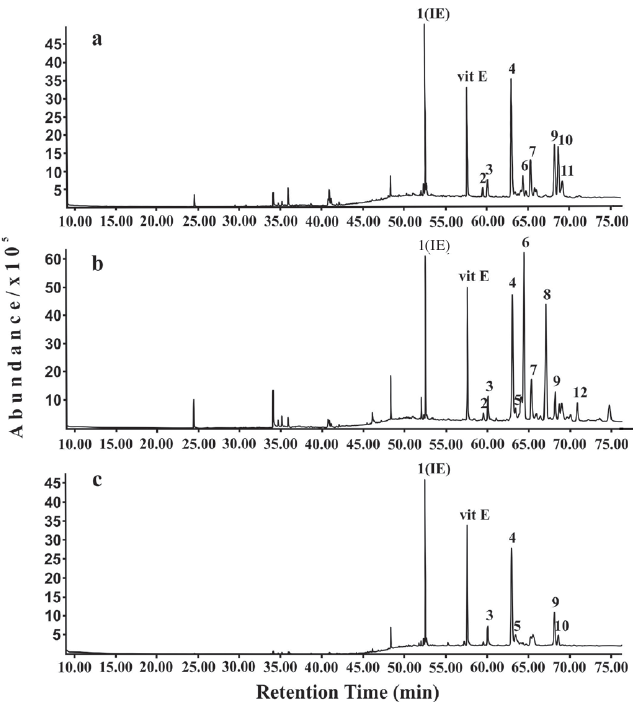
Fig. 1: Comparative GC-MS chromatograms of terpenes/sterols in Eche- veria species. (IS internal standard). (a) E. craigiana , (b) E. kim- nachii and (c) E. subrigida . The identification of the constituents is shown in Tab. 1.